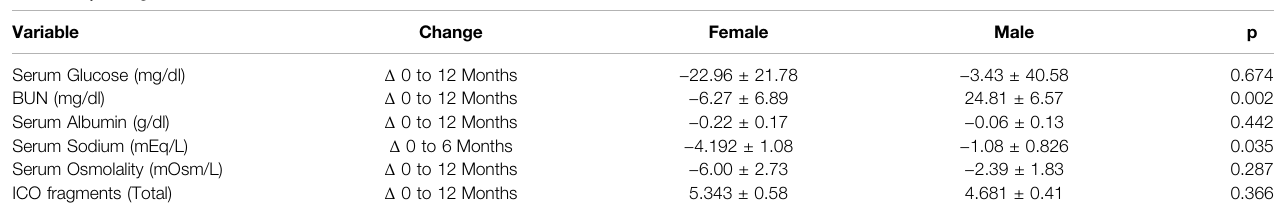
TABLE 3 | Changes from baseline values of selected biochemical